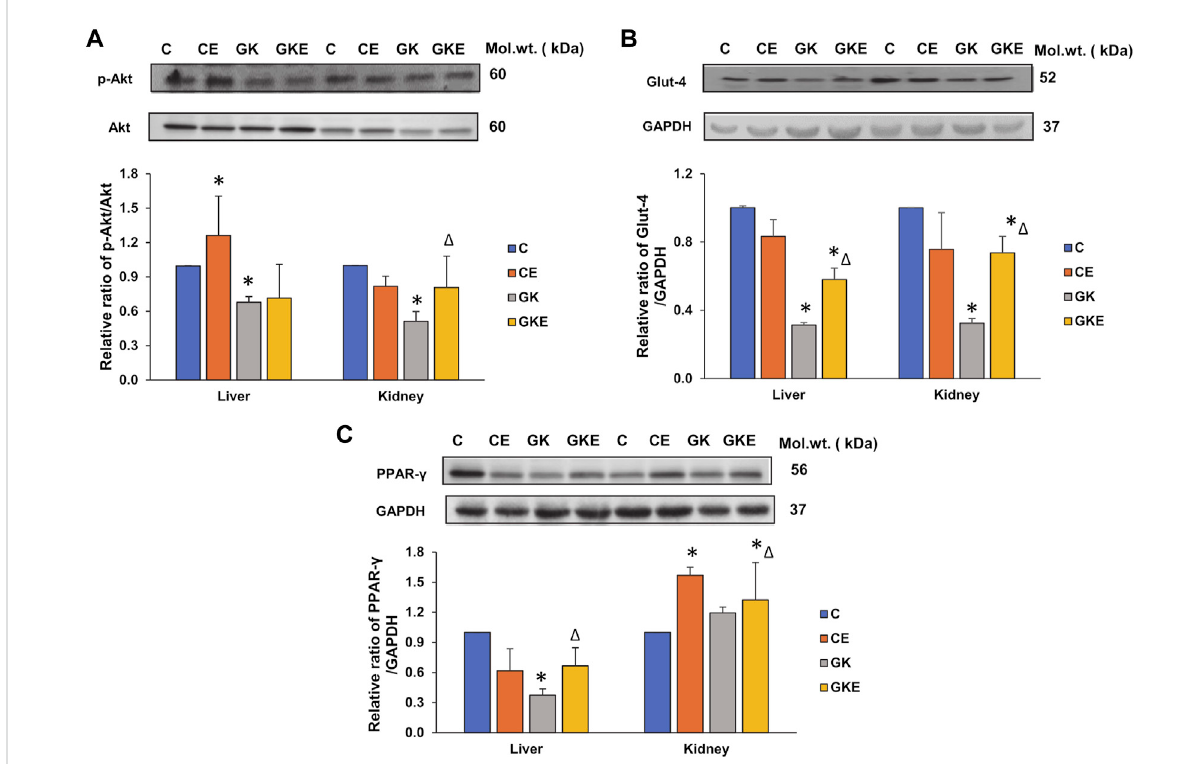
FIGURE 8 Exercise-induced alterations in the expression of cell-signaling metabolic marker proteins in the liver and kidney of control Wistar (C) and diabetic GK (GK) and exercise-trained control (CE) and GK (GKE) rats ( n = 5). Cytosolic fractions were electrophoretically separated by 12% SDS- PAGE, transferred onto nitrocellulose membranes, and immunoblotted with cell-signaling marker proteins, p-Akt (A) , glucose transporter protein, Glut-4 (B) ,andPPAR- γ (C) andvisualizedusingtheSapphireBiomolecularImager(AzureBiosystems,Dublin,OH,UnitedStates)orbyexposure to X-ray fi lms.Total protein or GAPDH was used as theloading control. Immunoreactive bands were quantitated using Image Studio Lite,ver.5.2 (LI- COR Biosciences, Lincoln, NE, United States). Histograms represent the relative ratio of protein to the loading control from three independent experiments.Statisticalsigni fi canceisshownasasterisks,whichwas fi xedas p < 0.05(*indicatesstatisticalsigni fi cancecomparedwithcontrolWistar rat tissues while Δ indicates statistical signi fi cance compared with diabetic GK rat tissues). Molecular weights of the respective proteins are indicated in kDa. Original western blot fi gures are shown in Supplementary Figure